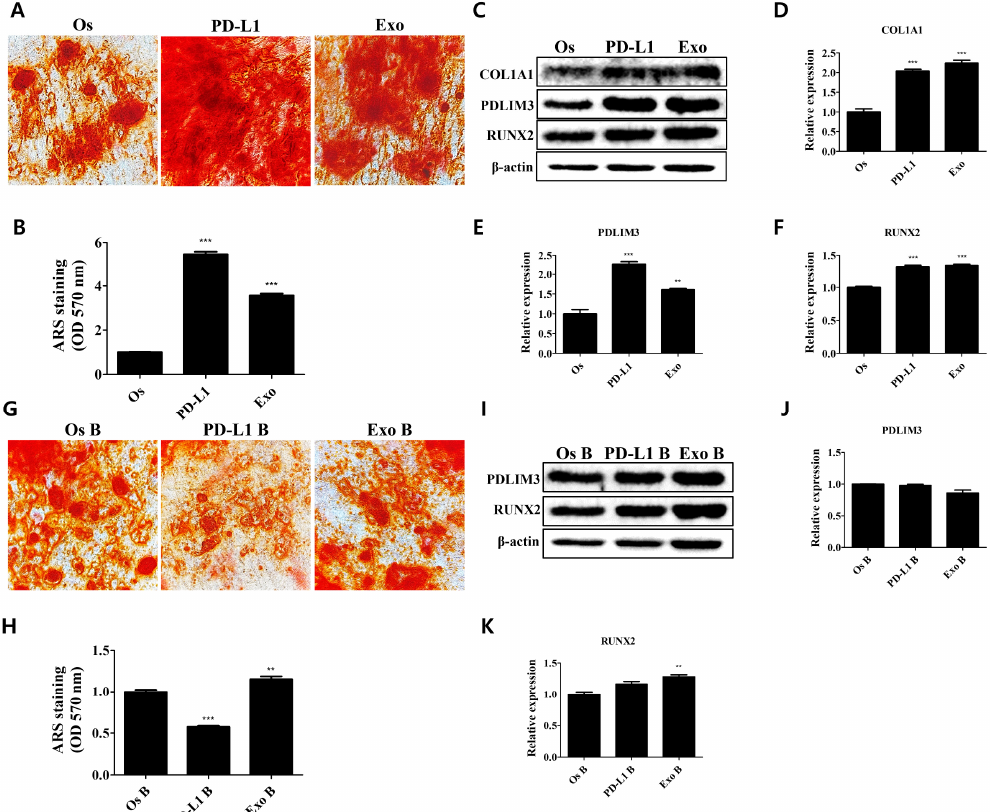
Figure 5. Regulatory effects of exosomal PD-L1 on bone matrix formation in osteoblasts. ( A ) Regulatory effects on the enhancement of matrix mineralization in PD-L1- and exosome-treated osteoblasts. ( B ) Stained calcium deposits were dissolved and quantified. N = 5 trials per sample and control. ( C ) Expres- sion levels of proteins mediating the osteogenic properties upon PD-L1 and exosome treatment. Relative expression levels of ( D ) COL1A1, ( E ) PDLIM3, and ( F ) RUNX2 in osteoblasts. N = 3 trials per sample and control. ( G ) Attenuation of the enhanced matrix mineralization in PD-L1- and exosome-treated osteo- blasts via blocking of PD-1/PD-L1 interaction. ( H ) Stained calcium deposits were dissolved and quanti- fied. N = 5 trials per sample and control. ( I ) Expression levels of proteins mediating the osteogenic prop- erties upon the inhibition of PD-1/PD-L1 interaction in PD-L1- and exosome-treated osteoblasts. Relative expression levels of ( J ) PDLIM3 and ( K ) RUNX2 in osteoblasts. N = 5 trials per sample and control. Data